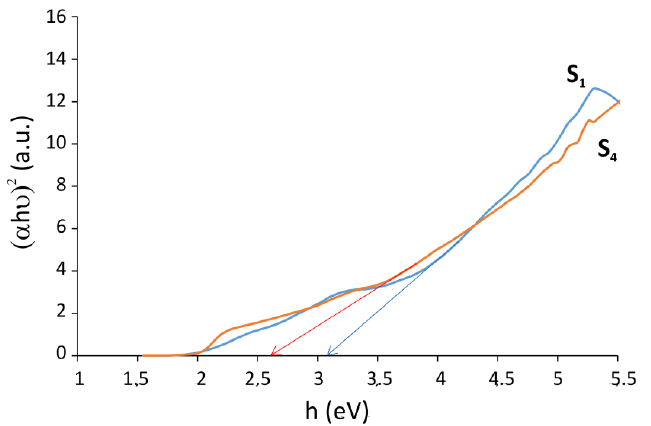
Figure 4. Tauc’s plot of the S 1 and S 4 samples.